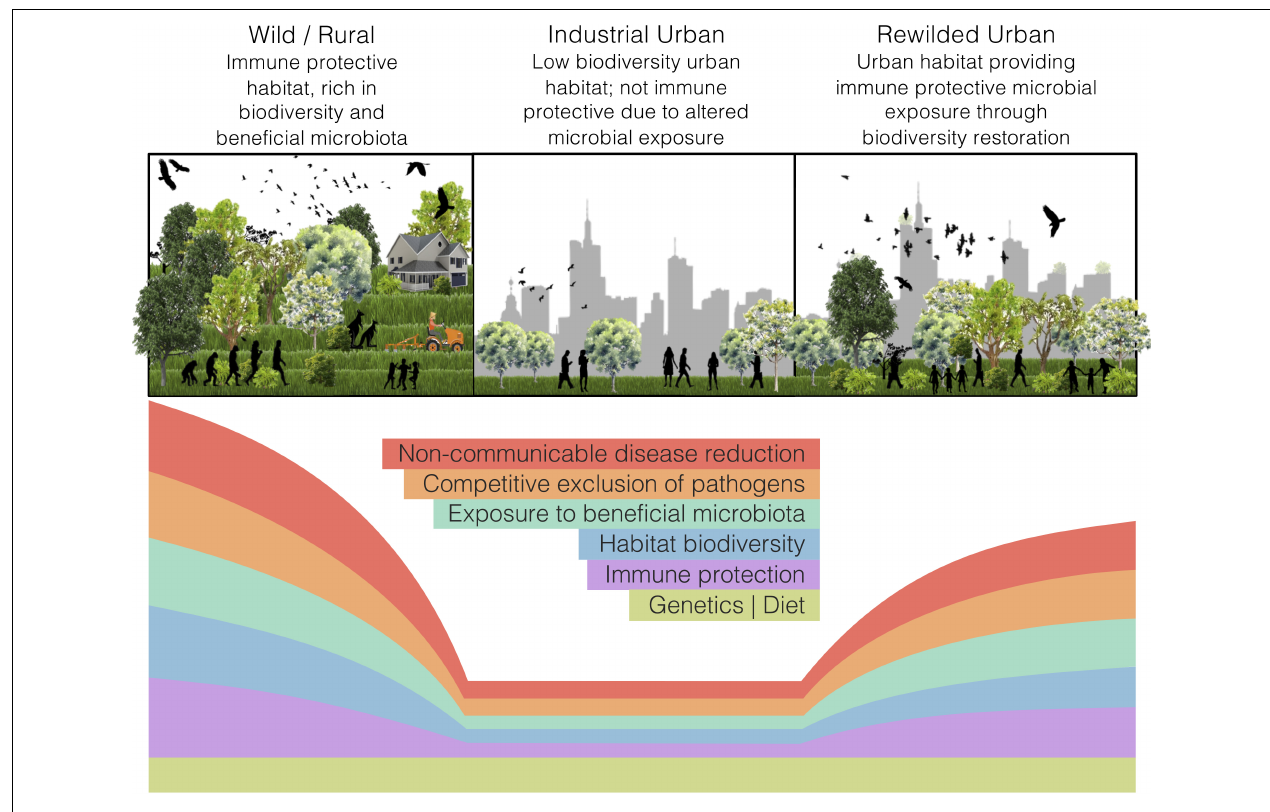
FIGURE 1 | The microbiome rewilding hypothesis proposes the return of human habitat to one high in microbial diversity and with wilder symbiotic, competitive, and predatory micro-ecological processes. States of human habitat have varied levels of biodiversity and microbiota exposure, immune protection, microbial processes, and non-communicable disease rates. Genetics and diet can remain the same across habitat